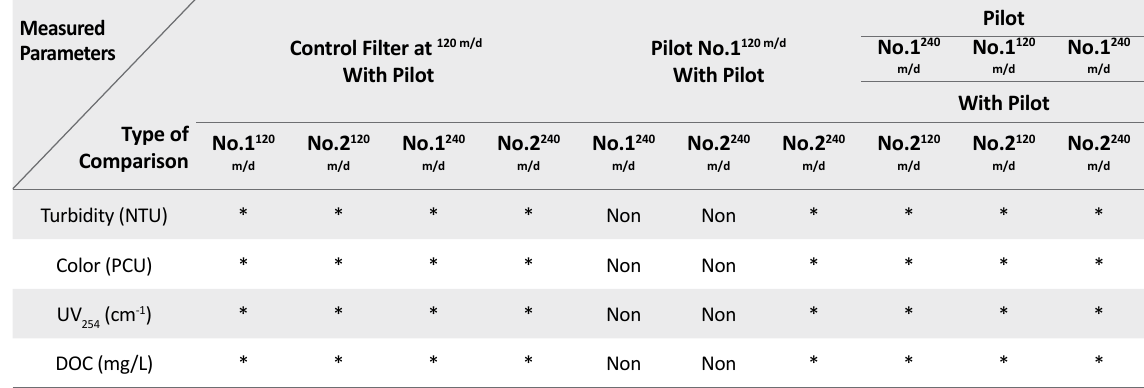
Table 5. Significant results of measured parameters between pilot input and output and filtration unit in different filtration rate Measured